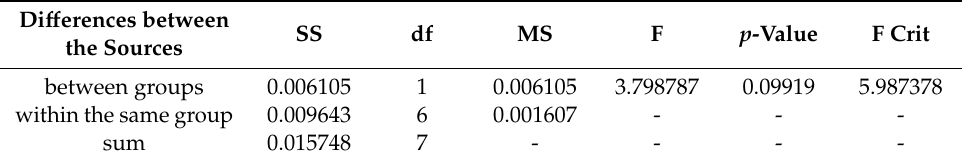
Figure 7. Average clustering coefficient of sandstone pore network. Table 2. One-way ANOVA. Table 2. One-way ANOVA.